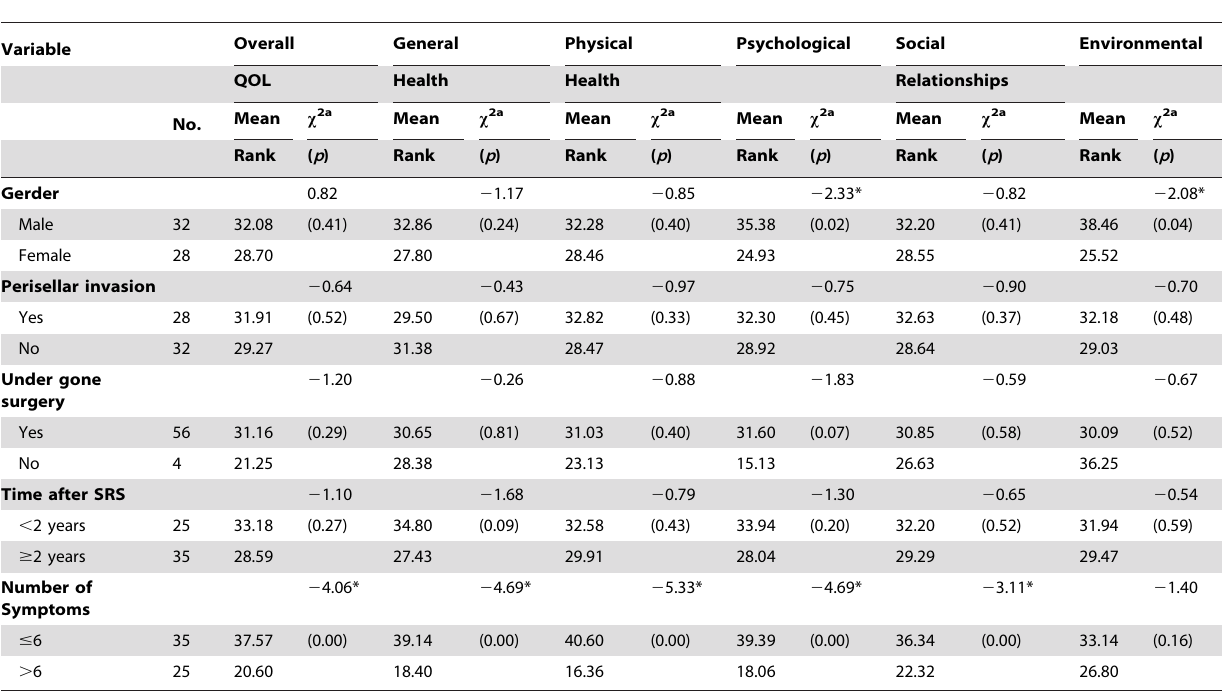
Table 4. Differences in personal characteristics, levels of symptom distress, and quality of life (QOL) ( n = 60).